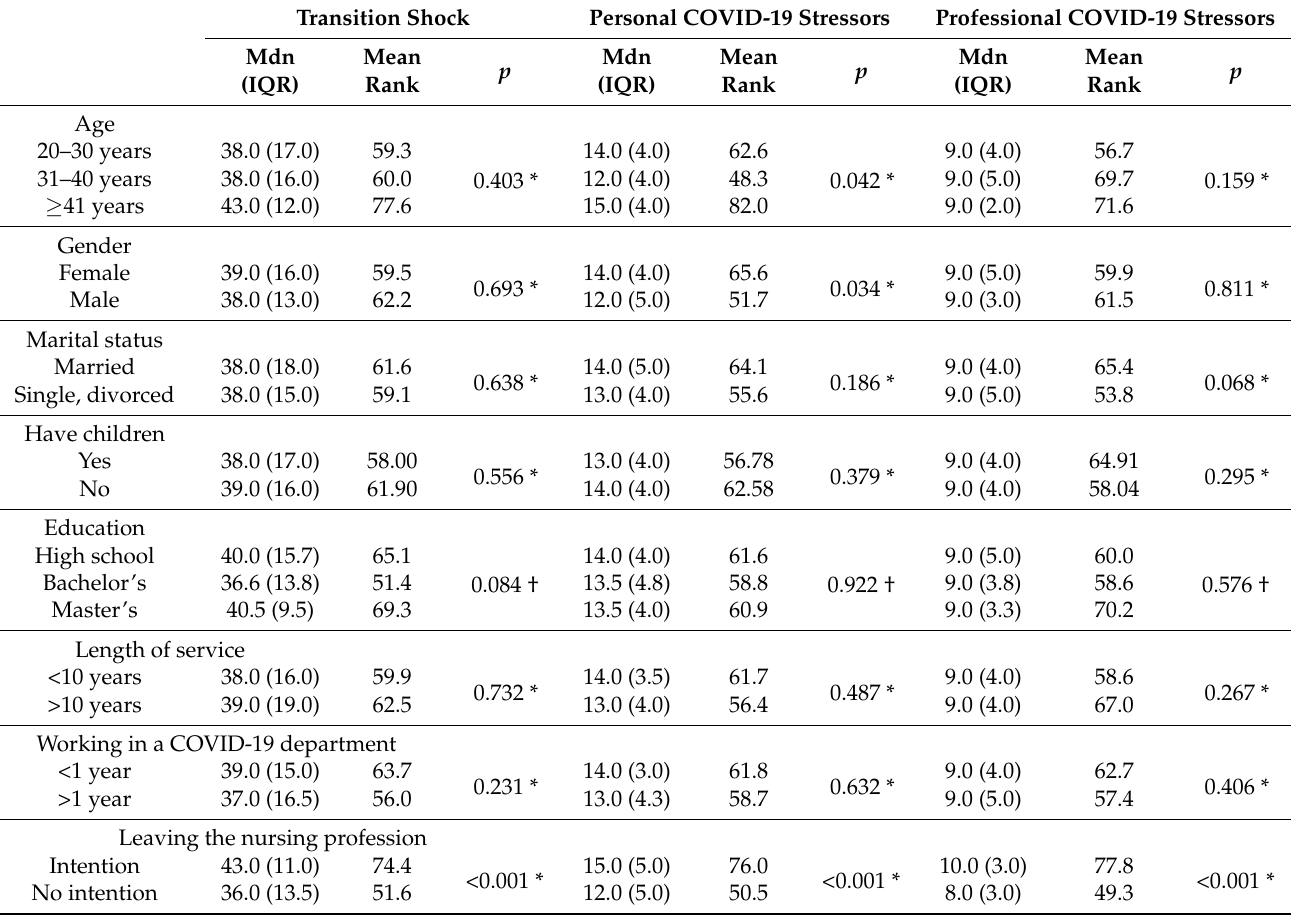
Table 2. Differences in transition shock and personal and professional COVID-19 stressors by sociodemographic chrematistics in a sample of nurse (N =